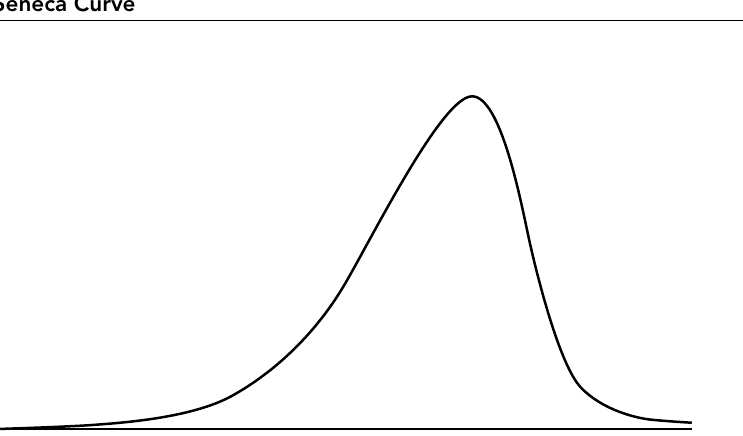
Figure 1. A typical “Seneca Curve” calculated by means of system dynamics. It shows how decline can be faster than